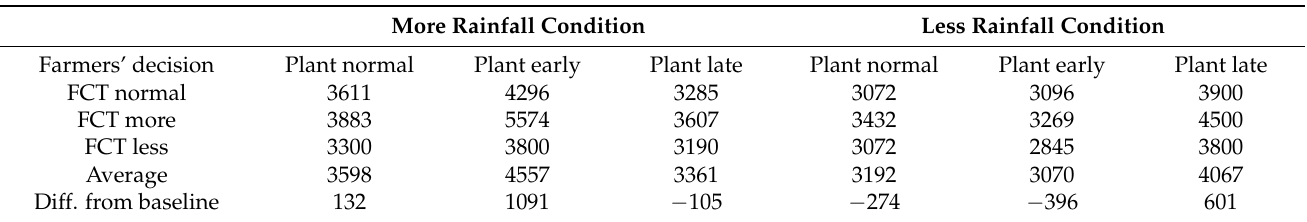
Table 4. Farmers’ decisions of planting time and usage of fertilizer, herbicides, and tillage frequencies under different rainfall conditions.